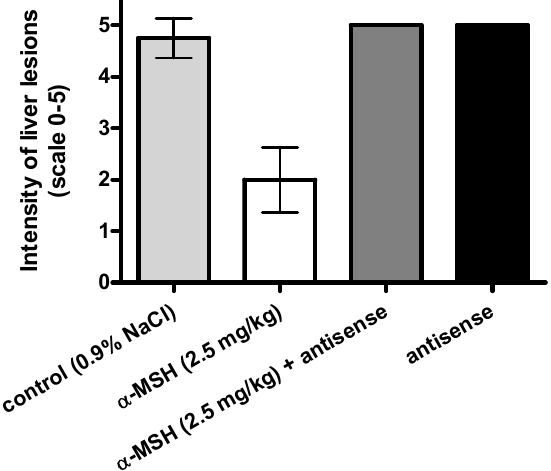
Figure 4. Modulation of α -MSH induced hepatoprotection by means of its antisense pentapeptide LVKAT. Effects of peptides on liver necrosis produced by acetaminophen (150 mg/kg